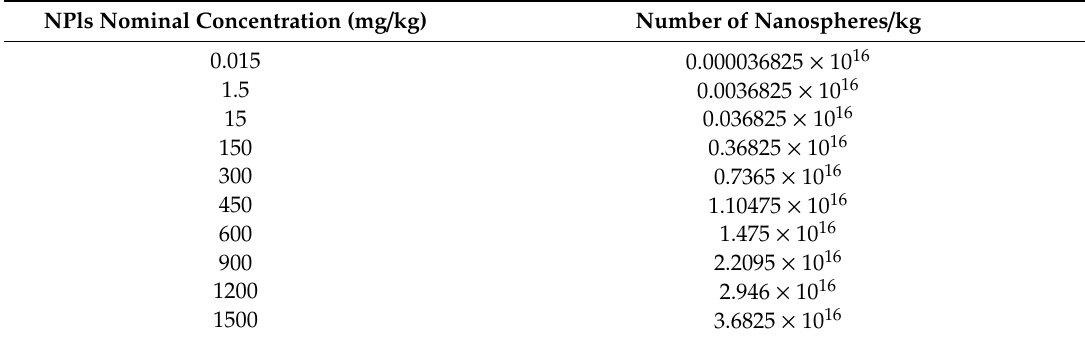
Table 2. Correspondence between the tested nominal concentrations of polystyrene nanoplastics (NPls) and the number of